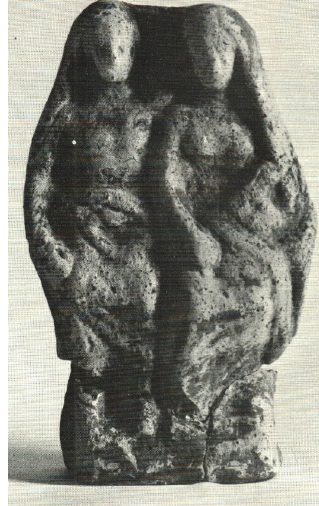
Figure 2. Gabii. From Almagro-Gorbea, “El santuario”, 273, n. 19, Tab. LIII 2. Following the same reasoning, at least three more statuettes from Gabii of couples with a child who is not seated frontally on the female’s knees, but reclined in her arms, might be understood as kourotrophoi with a male figure.23